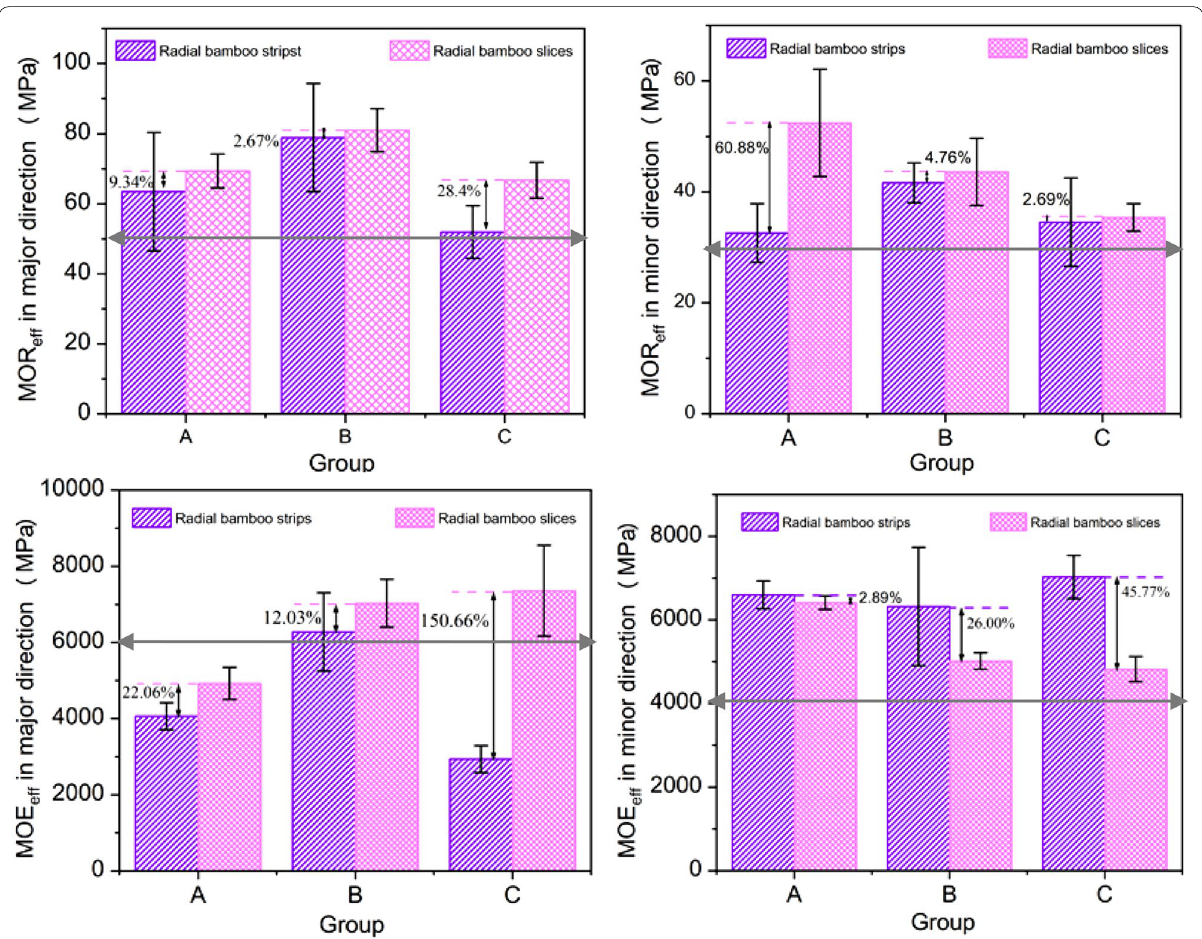
Fig. 7 MOReff and MOEeff of different layups in major and minor direction. Note “ bar indicates the C.V. of MOReff and